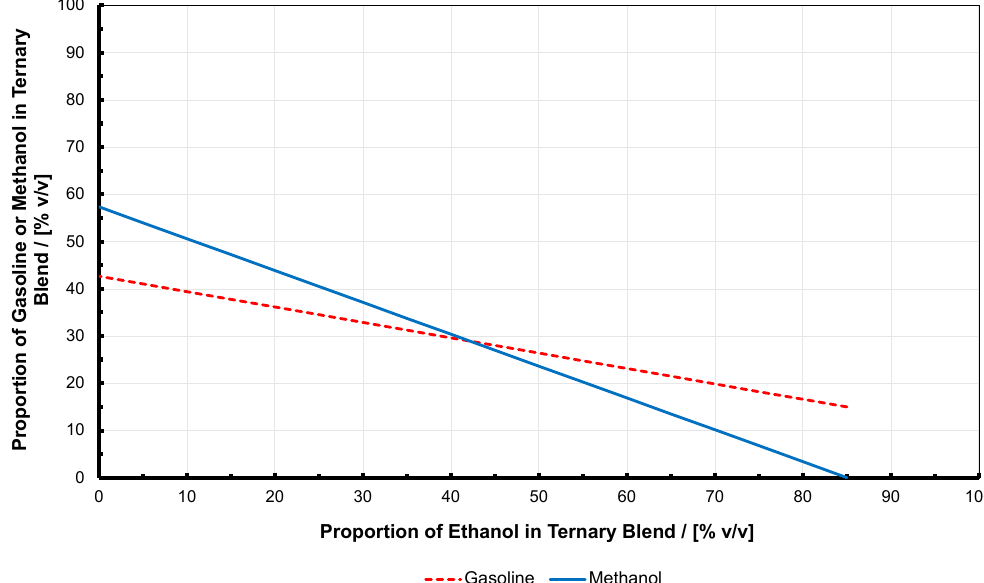
Figure 3. Representation of how the volume proportions of three blend constituents change for a targeted stoichiometric AFR equivalent to that of E85 (i.e., 9.7). Here these constituents are gasoline, ethanol, and methanol, and together in this form they are termed iso-stoichiometric ‘GEM’ ternary blends. When reading this figure, note that E85 is effectively on the right; where the lines end is the limit of being able to meet the stoichiometric AFR limit of 9.7. The equivalent where no ethanol is present (i.e., M56) is on the extreme left.